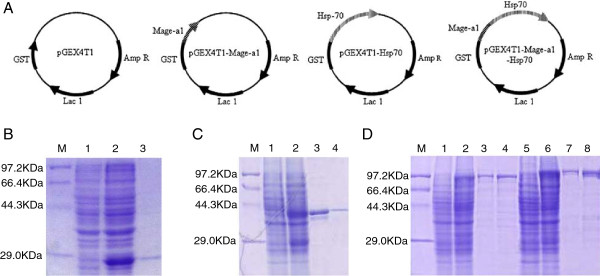
Construction of vectors and recombinant protein expression and purification. A. Schematic representation of recombinant pGEX4T1 vectors. Mage-a1 (aa118-219) gene segment, Hsp70 and Mage-a1-Hsp70 fusion gene were cloned into pGEX4T1 vector downstream of the GST sequence. B. GST protein was expressed by the vector pGEX4T-1 in E. coli Rosetta 2. M, protein molecular weight markers. Lanes 1–2, whole cell lysate without and with IPTG induction. Lane 3, purified GST protein. C. Mage-a1 protein expressed by recombinant vector pGEX4T-1-Mage-a1. M, protein molecular weight markers. Lanes 1–2, whole cell lysate without and with IPTG induction. Lanes 3–4, purified Mage-a1 protein at 2× or 1× loading concentration. D. Hsp70 and Mage-a1-Hsp70 protein expressed by recombinant vector pGEX4T-1-Hsp70 and pGEX4T-1-Mage-a1-Hsp70. M, protein molecular weight markers. Lanes 1–2, whole cell lysate of E. coli Rosetta 2 transformed with pGEX4T-1-Hsp70 without and with IPTG induction. Lanes 3–4, purified Hsp70 protein at 1× or 2× loading concentration. Lanes 5–6, whole cell lysate of E. coli Rosetta 2 transformed with pGEX4T-1-Mage-a1-Hsp70 without and with IPTG induction. Lanes 7–8, purified Mage-a1-Hsp70 protein at 1× or 2× loading concentration.